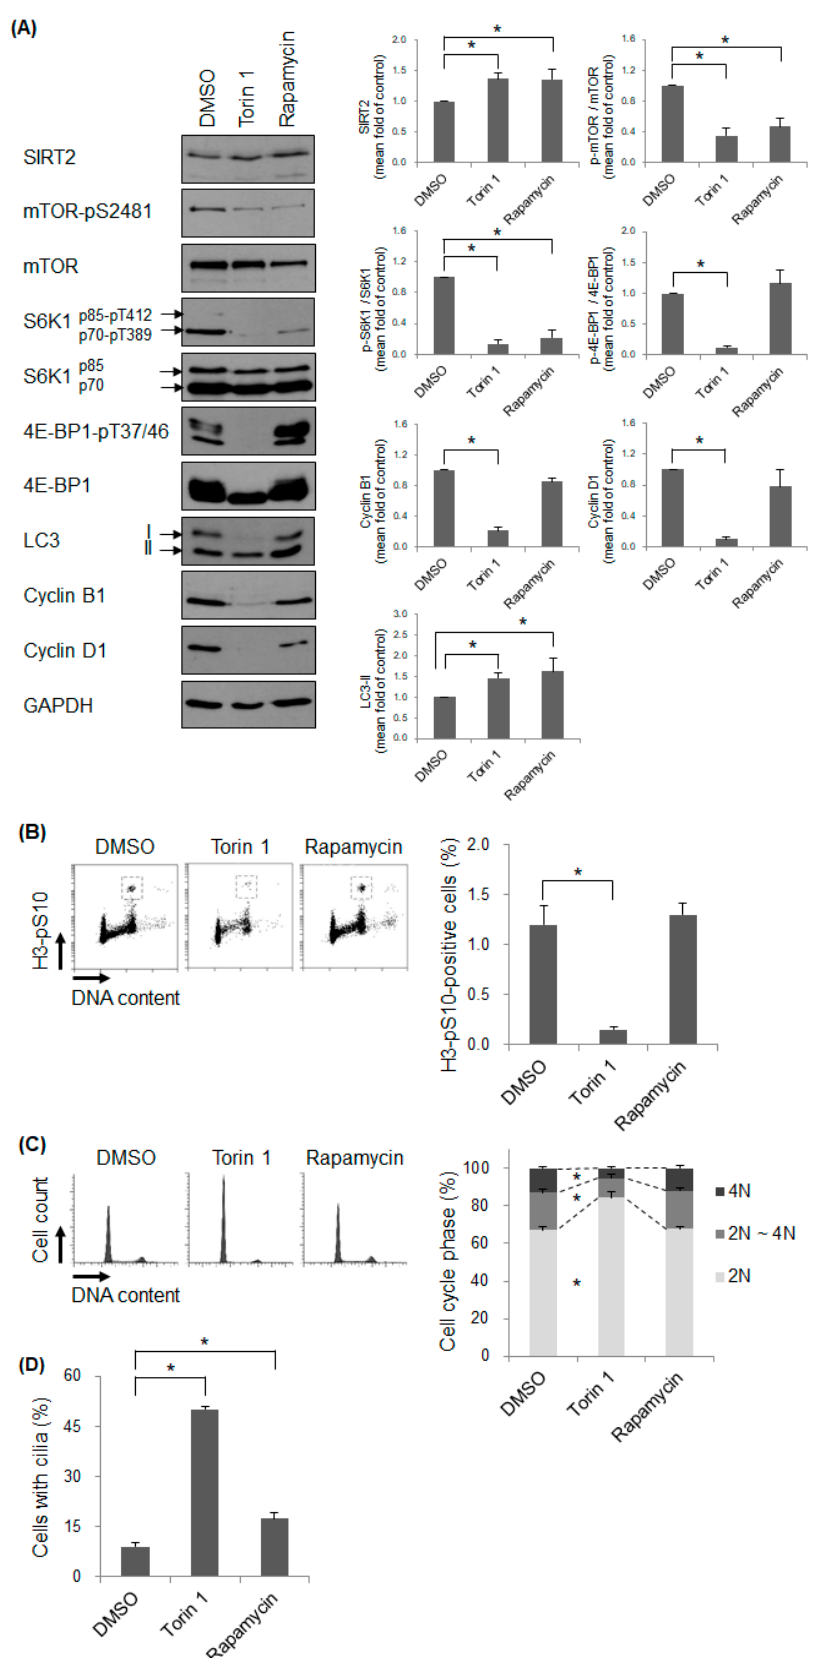
Figure 5. Inhibition of mTOR signaling induces cell cycle arrest and ciliogenesis. ( A–D ) hTERT-RPE1 cells were treated with 0.1% DMSO, 0.2 μ M torin 1, or 15 μ M rapamycin for 48 h. ( A ) Expression of mTOR, its substrates, LC3, and cyclins was determined by Western blotting. Relative expression is presented as the mean ± SEM ( n = 5). * p < 0.05; significantly different from DMSO-treated cells (Kruskal–Wallis test followed by Dunn’s multiple comparison); ( B , C ) Mitotic cells and DNA content were determined by flow cytometry after staining cells with an anti-histone H3-pS10 antibody and propidium iodide. The proportion of mitotic cells ( B ) and percentage of cells at each stage of the cell cycle ( C ) are expressed as the mean ± SEM ( n = 4). * p < 0.05; significantly different from DMSO-treated cells (one-way ANOVA followed by Tukey’s HSD test); ( D ) The number of ciliated cells (out of 200 cells) was counted and expressed as the mean ± SEM ( n = 5). * p < 0.05; significantly different from DMSO-treated cells (one-way ANOVA followed by Tukey’s HSD test). 3. Discussion Here, we show that SIRT2 suppression leads to a cell cycle arrest and subsequent formation of primary cilia by inhibiting mTOR signaling. In addition, we show that the effects of SIRT2 on mTOR signaling and cilia formation were dependent on nutrient status. Overall, the data suggest that SIRT2 is a functional hub that links nutrient signaling and primary cilia formation (Figure 6).